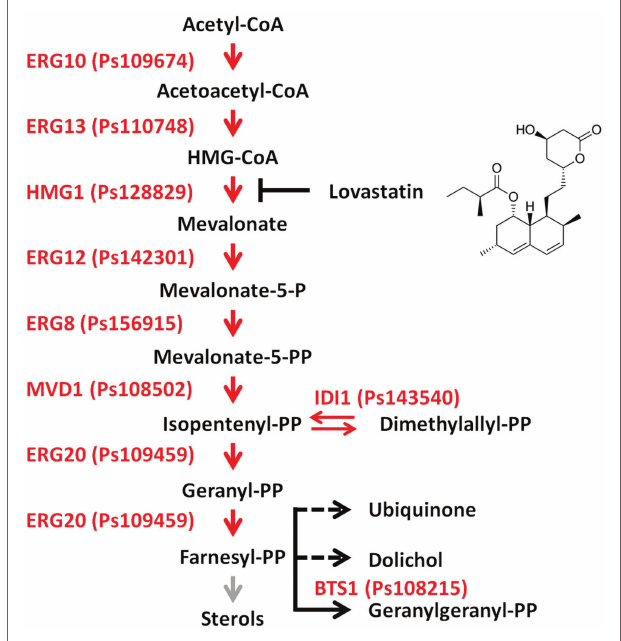
FIGURE 1 | Overview of the mevalonate (MVA) pathway in Phytophthora sojae . Enzymes and the corresponding gene ID of the MVA pathway in P. sojae are shown beside each arrow head. The main trunk of the MVA pathway is indicated by red arrows. The grey arrow indicated the deficient sterol biosynthesis sub-branch in Phytophthora species. The black arrow indicated the GGPP biosynthesis sub-branch, while the dashed arrow indicated that the sub-branches were not reported in Phytophthora species. The enzyme inhibitor lovastatin and chemical structure are also indicated on the right of the pathway. Acetyl-CoA, acetyl coenzyme A; Aceto-acetyl-CoA, aceto-acetyl coenzyme A; HMG-CoA, 3-hydroxy-3-methylglutaryl coenzyme A; Mevalonate-5-P, mevalonate phosphate; Mevalonate-5-PP, mevalonate diphosphate; Isopentenyl-PP, isopentenyl diphosphate; Dimethylallyl-PP, dimethylallyl diphosphate; Geranyl-PP, geranyl diphosphate; Farnesyl-PP, farnesyl diphosphate; and Geranylgeranyl-PP, geranylgeranyl